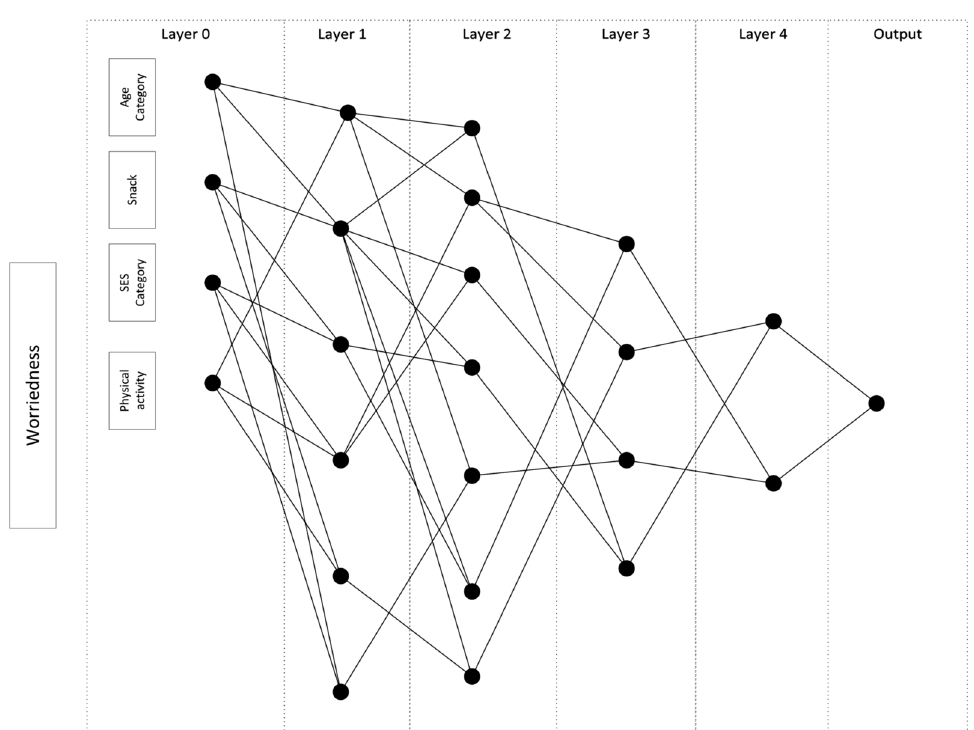
Figure 4. A representative GMDH network for classifying worriedness